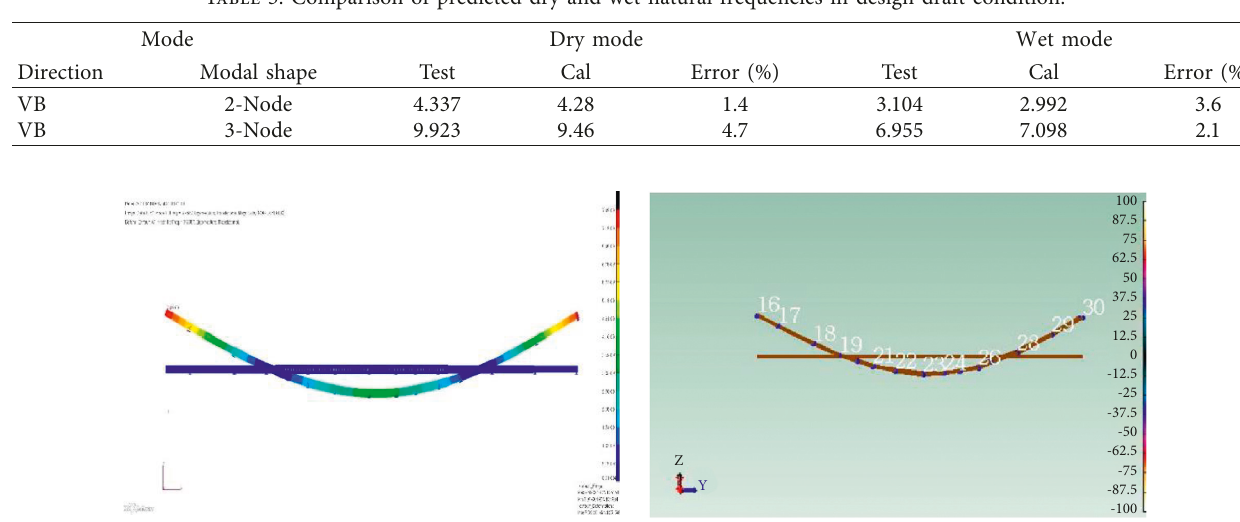
Table 5: Comparison of predicted dry and wet natural frequencies in design draft condition.